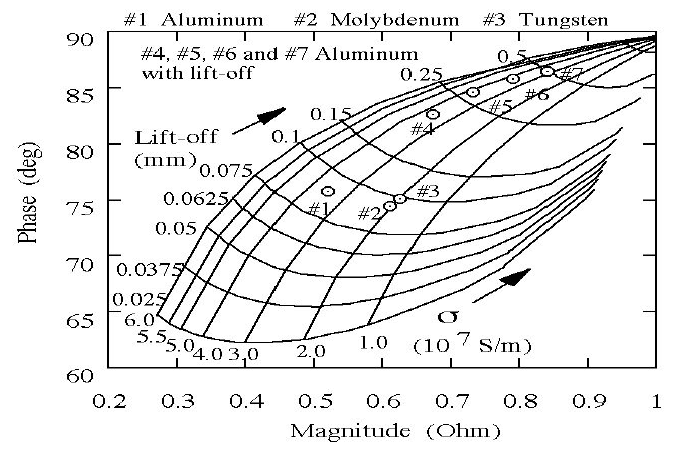
Figure 28. Estimation of surface